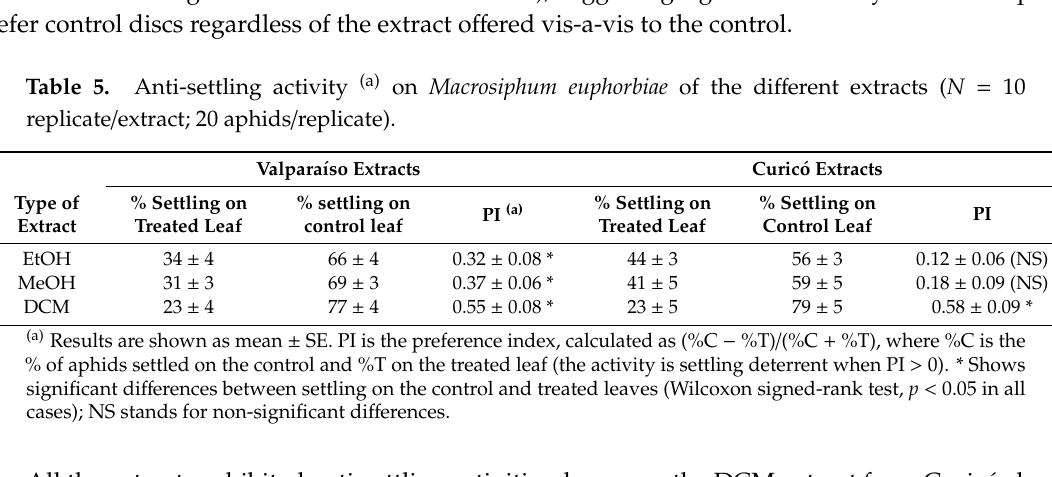
Table 5. Anti ‐ settling activity (a) on Macrosiphum euphorbiae of the different extracts ( N = 10 replicate/extract; 20 aphids/replicate). Valparaíso Extracts Curicó Extracts